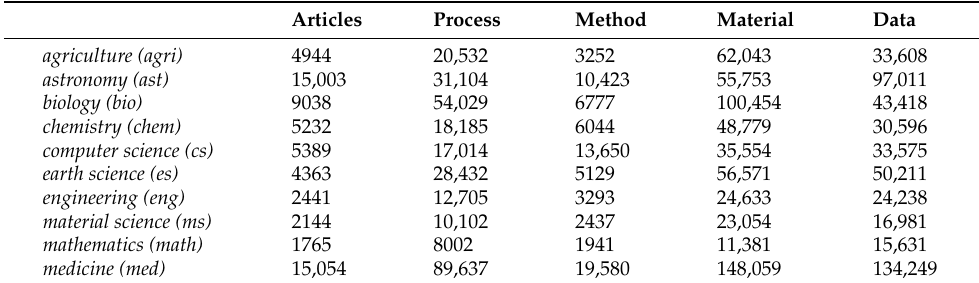
Table 1. STEM-NER-60k corpus statistics comprising 59,984 articles structured in terms of process, method, material, and data